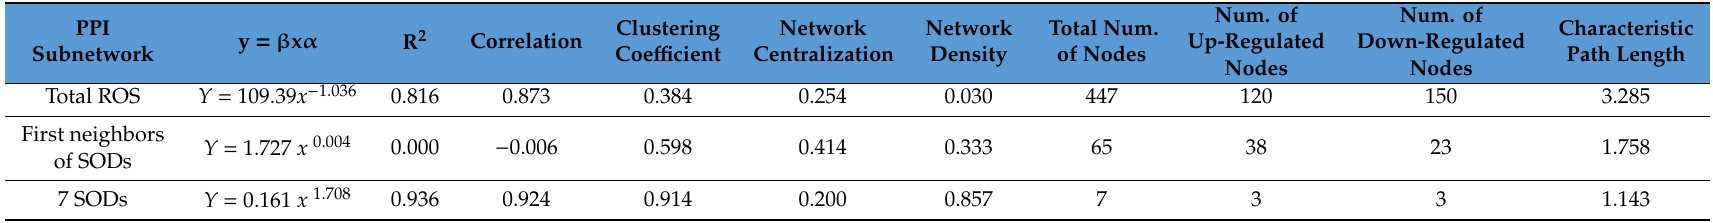
Table 3. Topological parameters of the total ROS related genes, a first neighbor of SODs and 7 SODs PPI networks of H. undatus regulated by